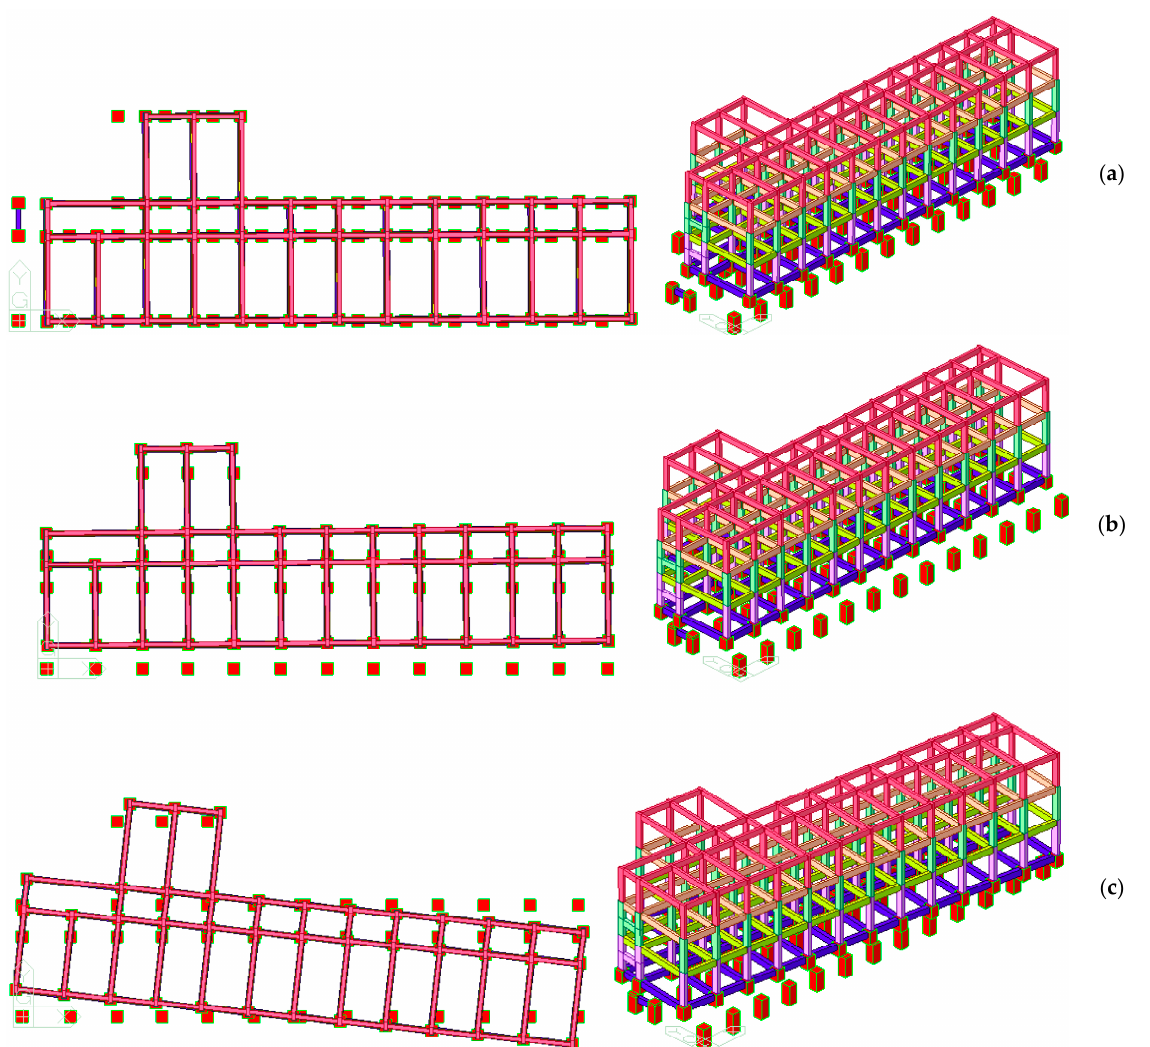
Figure 16. Fundamental vibration modes of the MIS system (Midas): top view and axonometric view: ( a ) longitudinal; ( b ) transverse; ( c ) torsional mode shapes.